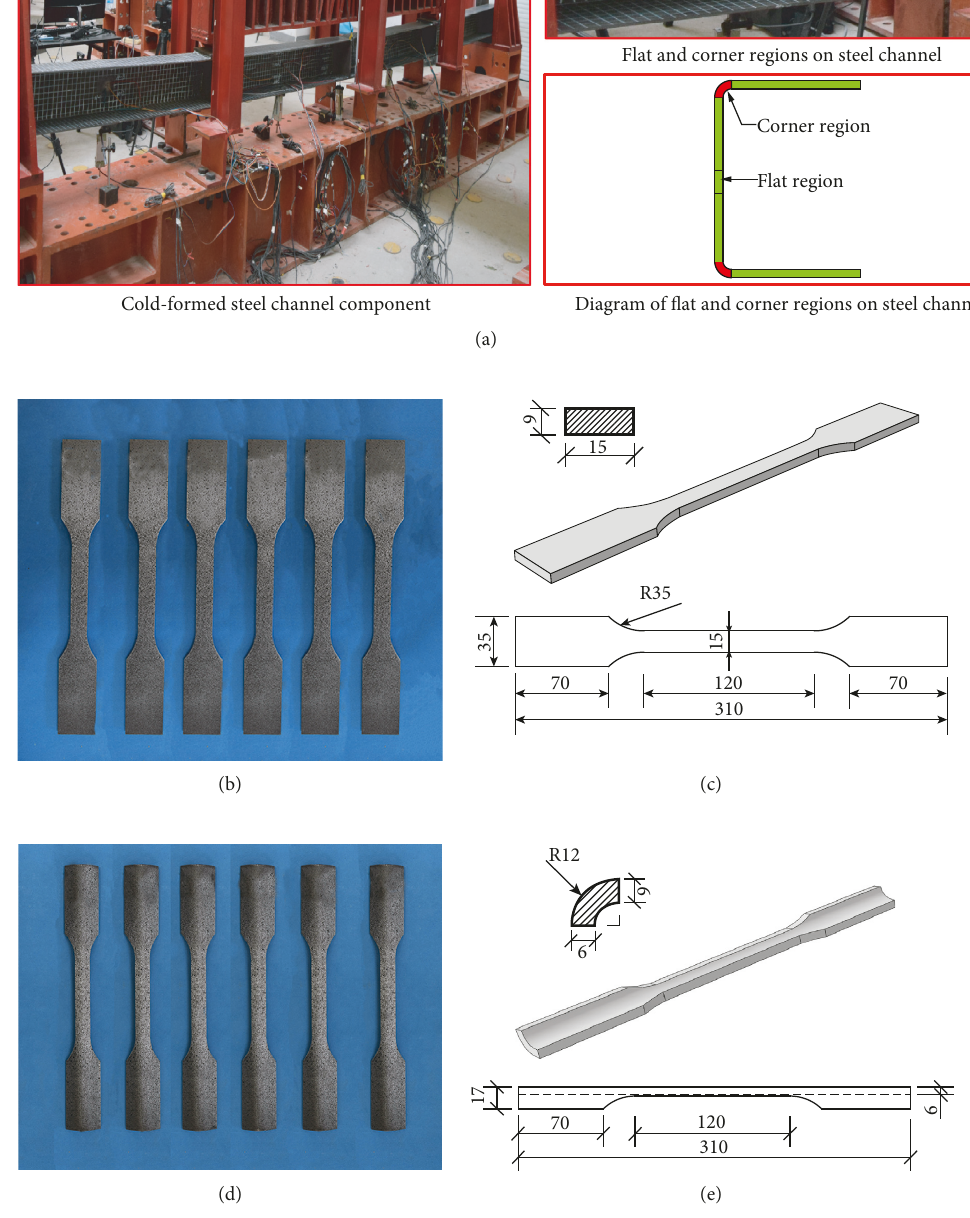
Figure 3: Fabrication and dimensions of flat and corner coupons from the cold-formed steel channel component: (a) flat and corner regions of cold-formed section; (b) flat coupons; (c) dimensions of flat coupon; (d) corner coupons; (e) dimensions of corner